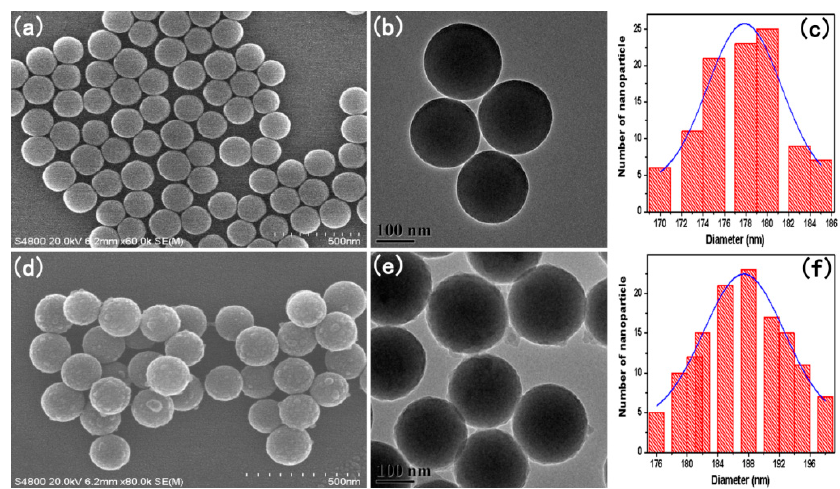
Figure 1. Scanning electron microscope (SEM) and Transmission electron microscope (TEM) images of SiO 2 ( a , b ) and SiO 2 @PMDA-Si ( d , e ). Histograms of nanoparticle size distribution of SiO 2 ( c ) and SiO 2 @PMDA-Si ( f ).